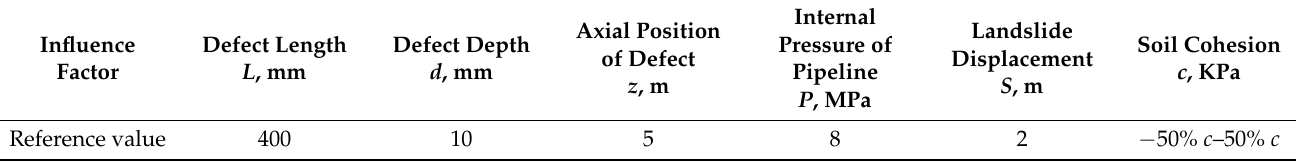
Table 10. Model parameters for varying soil